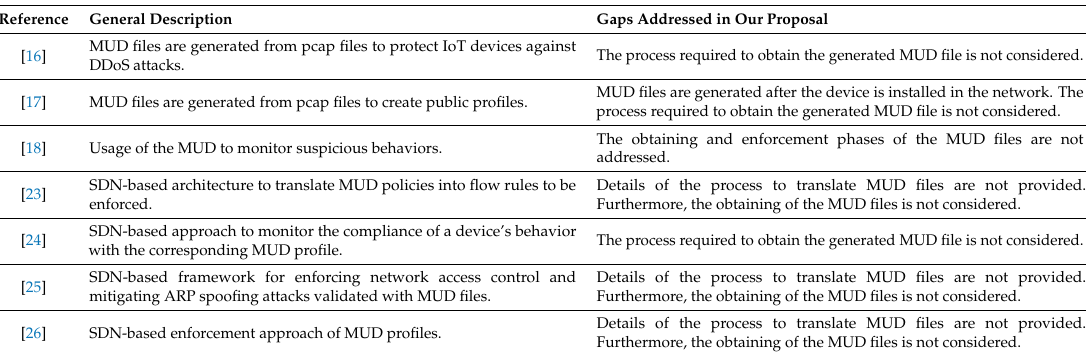
Table 1. Comparison with existing